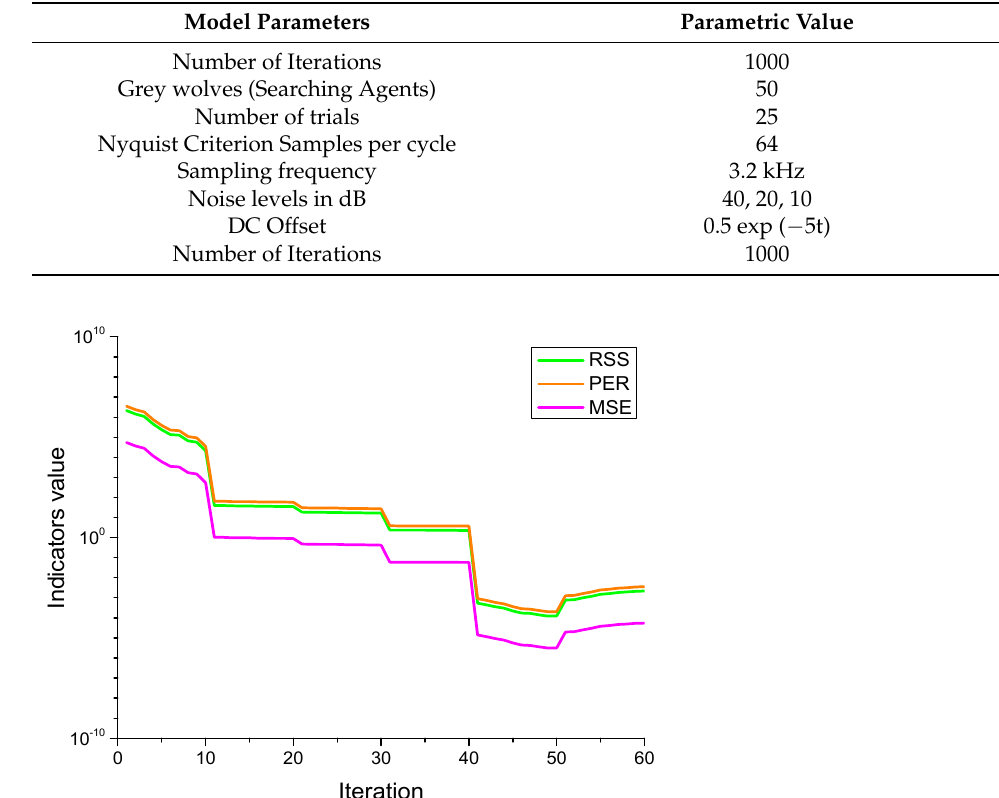
Table 3. Case Study I Parameters for Simulation.